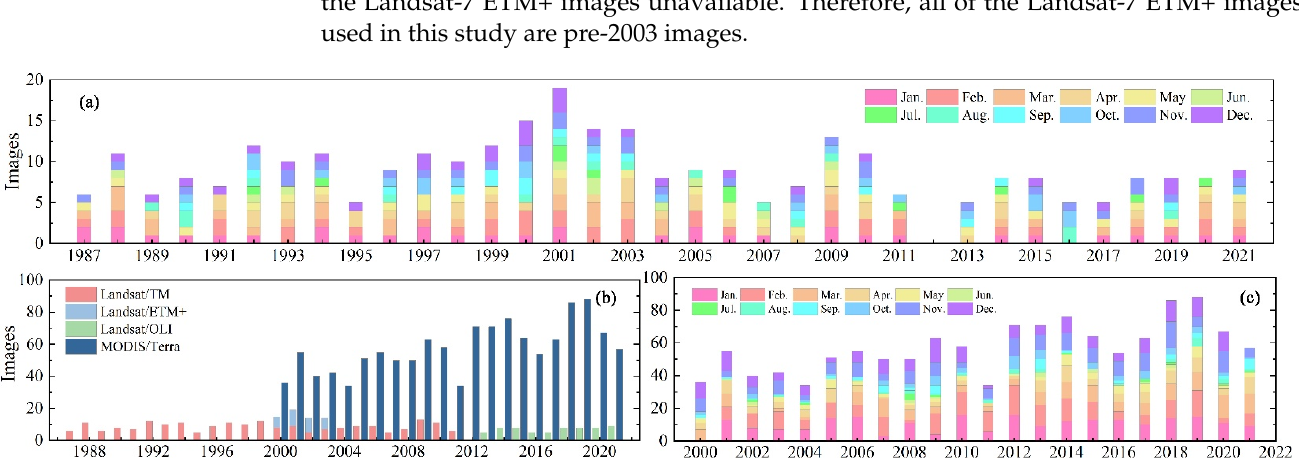
Figure 2. Temporal distributions of the Landsat TM/ETM+/OLI and MODIS/Terra scenes examined in this study. ( a ) Distributions of the Landsat scenes examined in this study. ( b ) Distributions of the Landsat TM/ETM+/OLI and MODIS/Terra scenes examined in this study from the period 2000–2021. ( c ) Distributions of the MODIS/Terra scenes examined in this study.